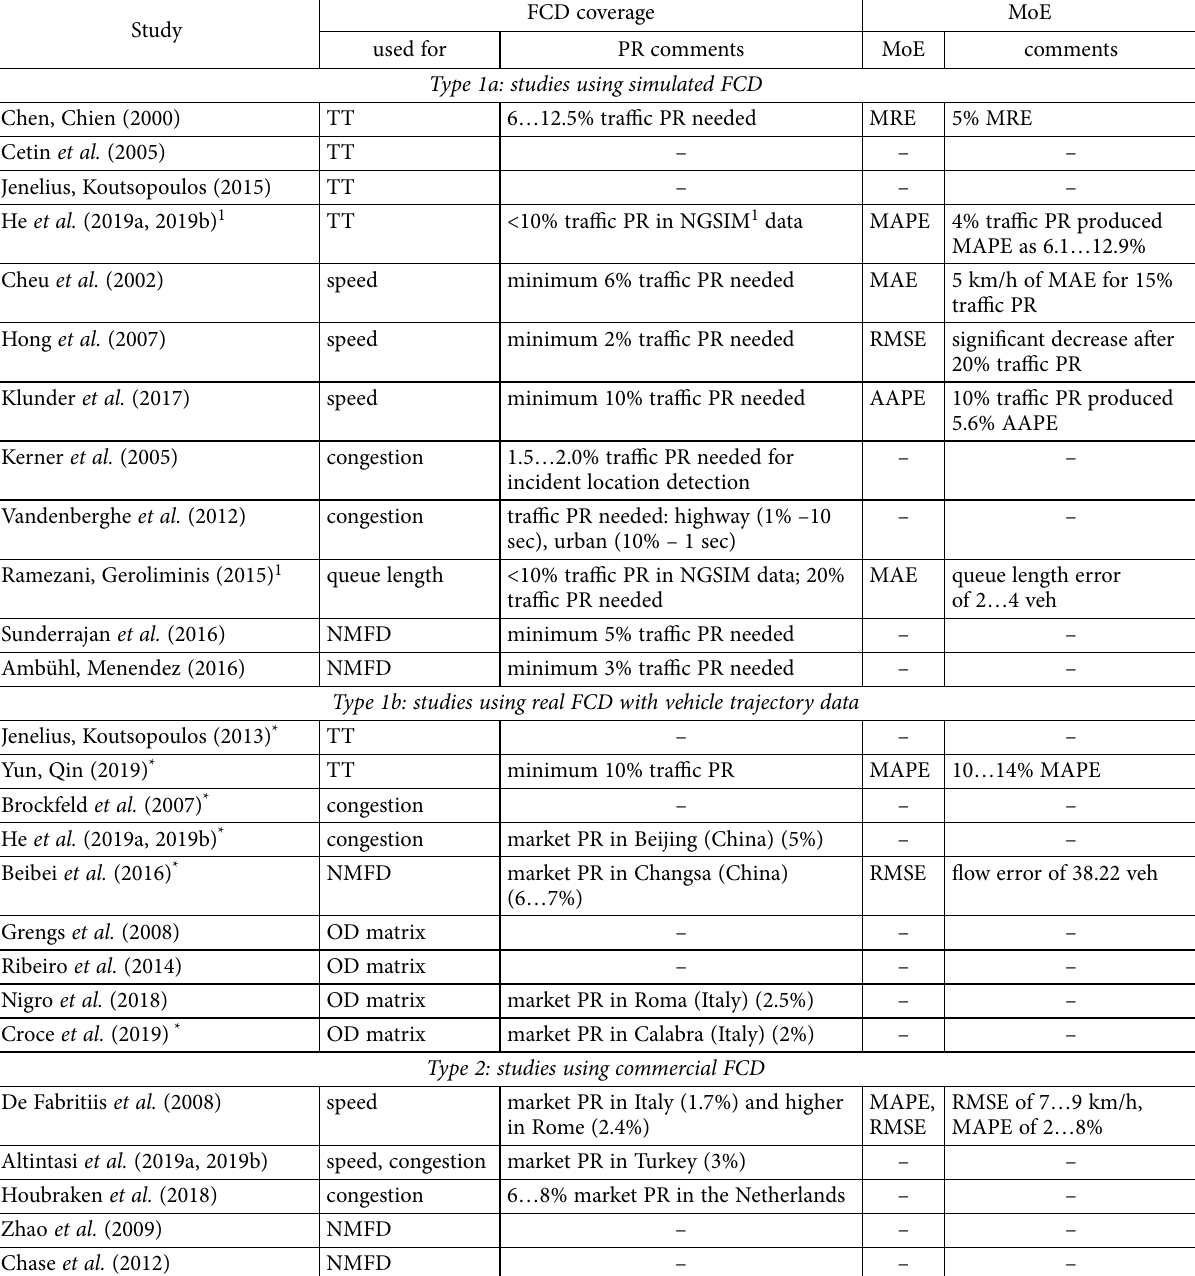
Table 1. Overview of probe vehicle based (Type 1) and commercial (Type 2) FCD